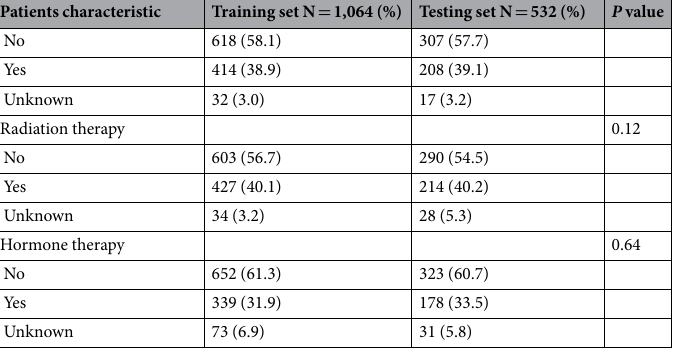
Table 1. Characteristics of patients in the training and testing sets. Abbreviations: SD, standard deviation. a Others include colloid, medullary, tubular, papillary carcinoma, and Paget’s